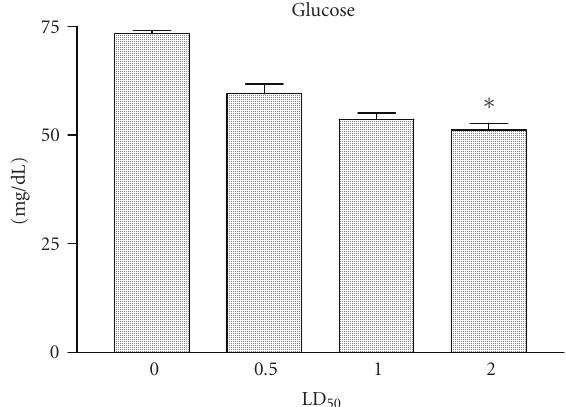
Figure 3: Urea determination . Groups of female mice from the BALB/c strain, 13–15 g of body weight, were injected i.p. with 0.5, or 1, and/or 2 LD 50 of Cdt. After 2 hours the mice were bled and the urea levels present in sera were determined. Each vertical bar represents the mean plus or minus the standard deviation value of samples from the results obtained with two experiments carried out with two independent groups of five mice each. Statistical di ff erences between the injections were marked with asterisk ( P < .